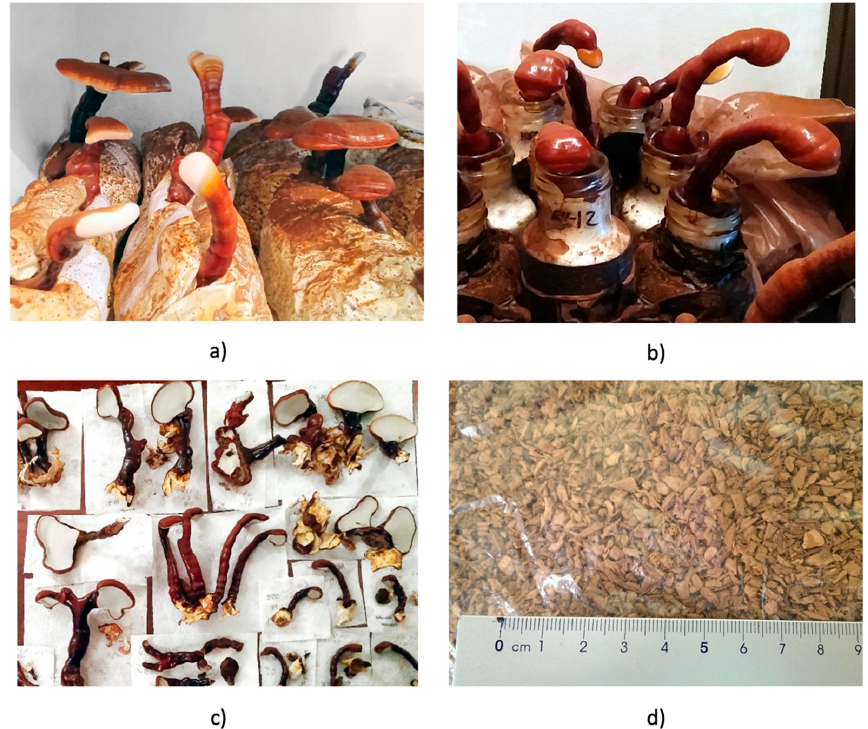
Figure 1. Photograph of Ganoderma lucidum (GL) and Ganoderma lingzhi (GZ) crops. ( a ) Colonized bags and fruit body production of GL; ( b ) Jars with fruiting bodies of different strains of GL; ( c ) GL mushrooms harvested and dried; ( d ) Chopped GZ carpophores.